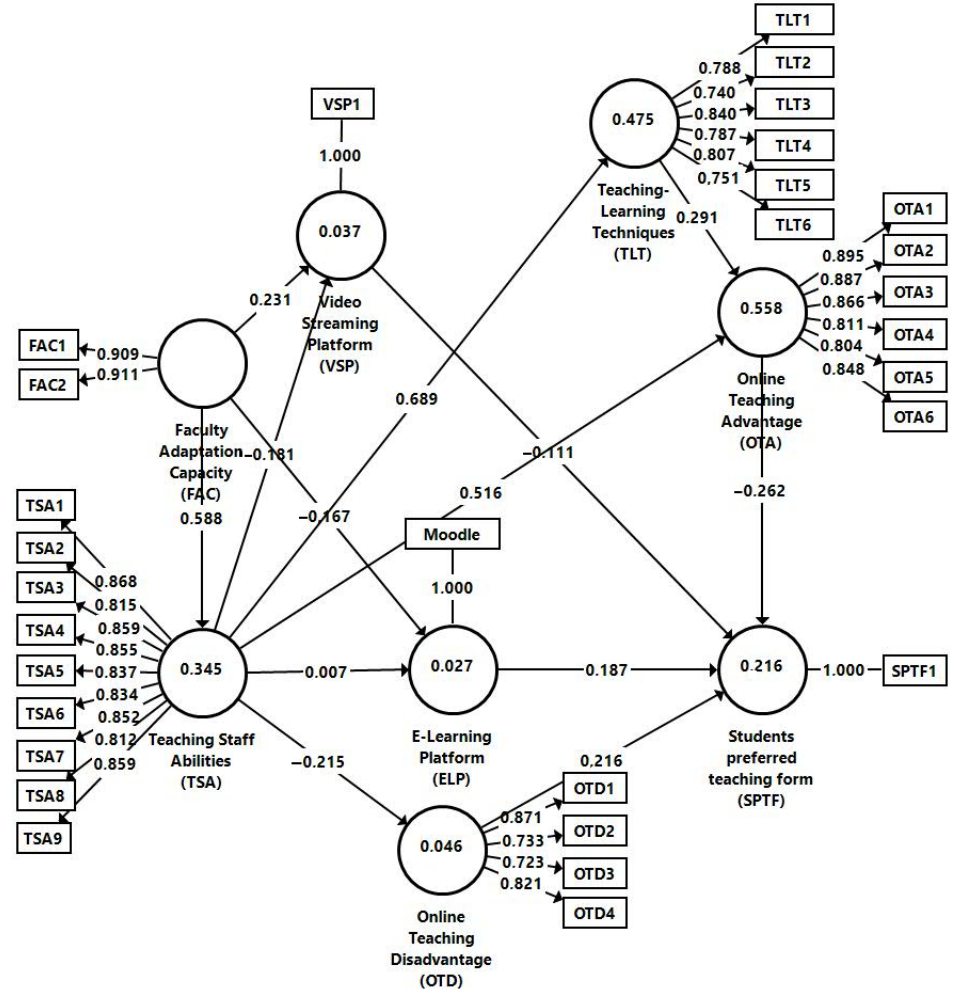
Figure 2. Structural model. Source: own computation in SmartPLS.